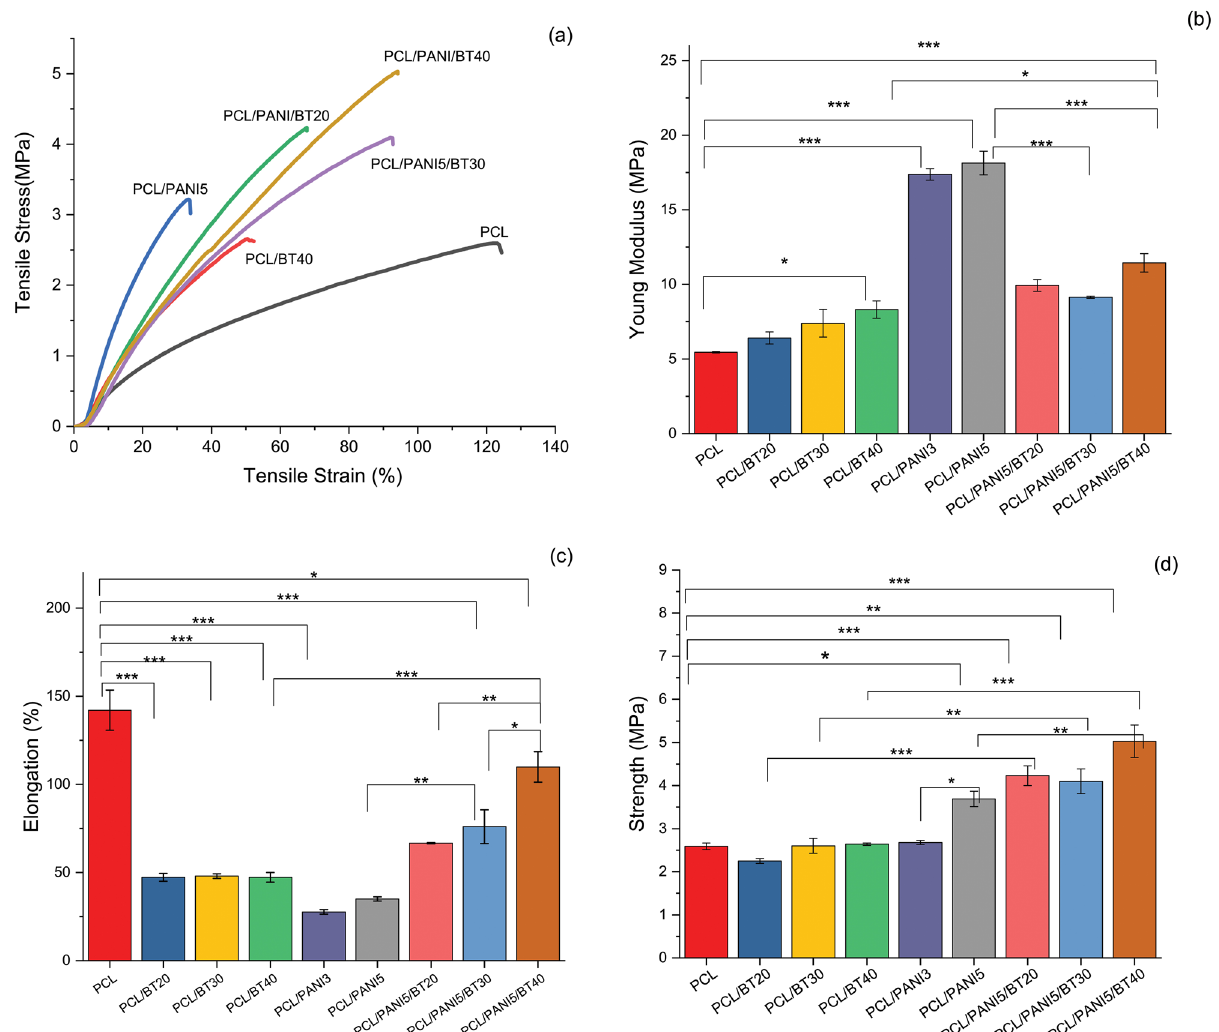
Figure 5. Mechanical properties of nanofibrous scaffolds: ( a ) stress–strain curves ( b ) Young’s modulus ( c ) Elongation at break, and ( d ) Tensile strength. Pure PCL nanofibrous scaffold has poor stiffness and UTS, but high elongation. The addition of PANI nanoparticles to the PCL, nanofibers gained stiffness, but gradually lost their elasticity, due to the PANI’s naturally hard and brittle properties. Adding BT NPs cause to increase in the Young’s modulus and decrease in elongation. Comparing ternary nanocomposite sample with others, stiffness has improved, and elasticity has set in a desirable amount for various tissues application.